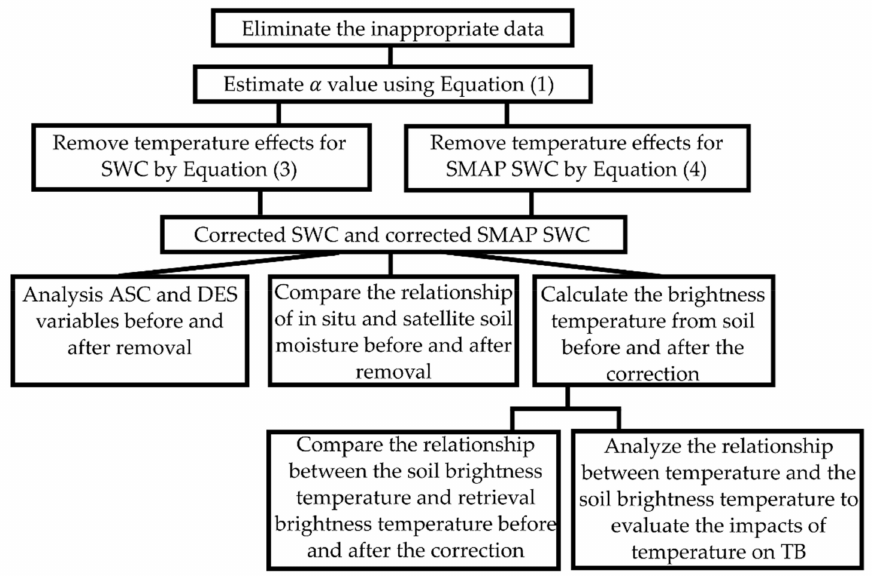
Figure 5. A schema of the temperature effects removal and analysis